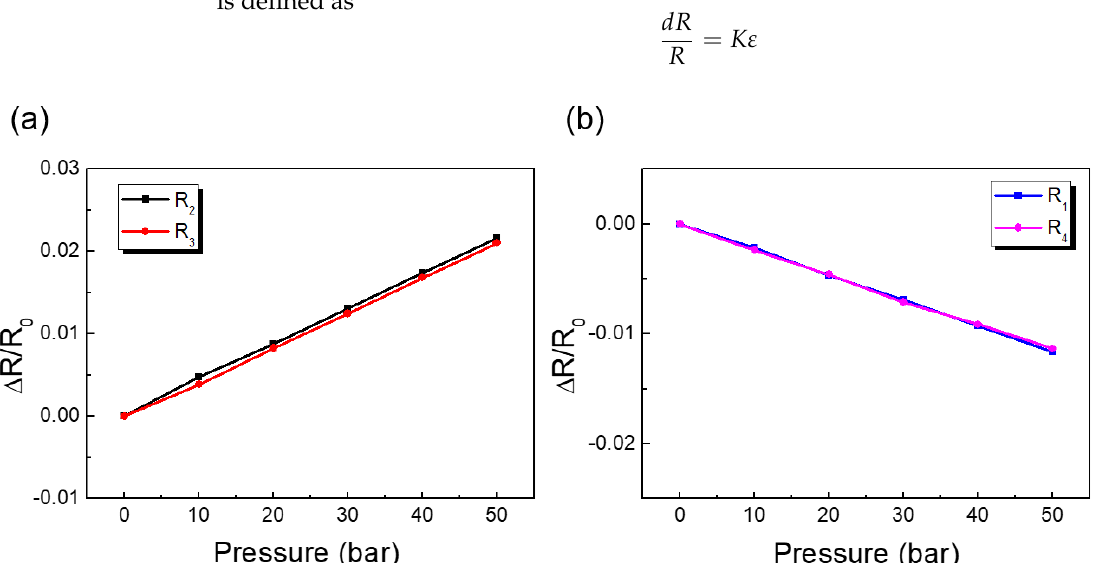
Figure 13. Variations of relative charge in gauge resistance with strain for ( a ) two tangential gauges and ( b ) two radial gauges. Table 2. Summary of the sensitivity of tangential and radial gauges according to Equation (3).